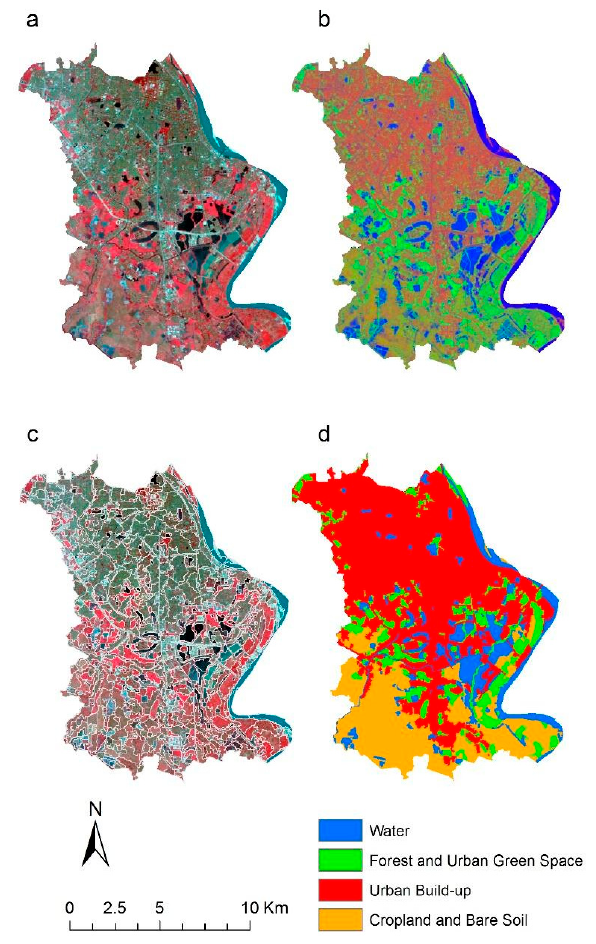
Figure 5. An example of the object-based classification of the urban districts in Hanoi, Vietnam: ( a ) Landsat TM image; ( b ) color composite image of MNDWI (blue); NDVI (green) and NABI (red); ( c ) segmented image objects; and ( d ) object-based classification after knowledge-based manual correction.